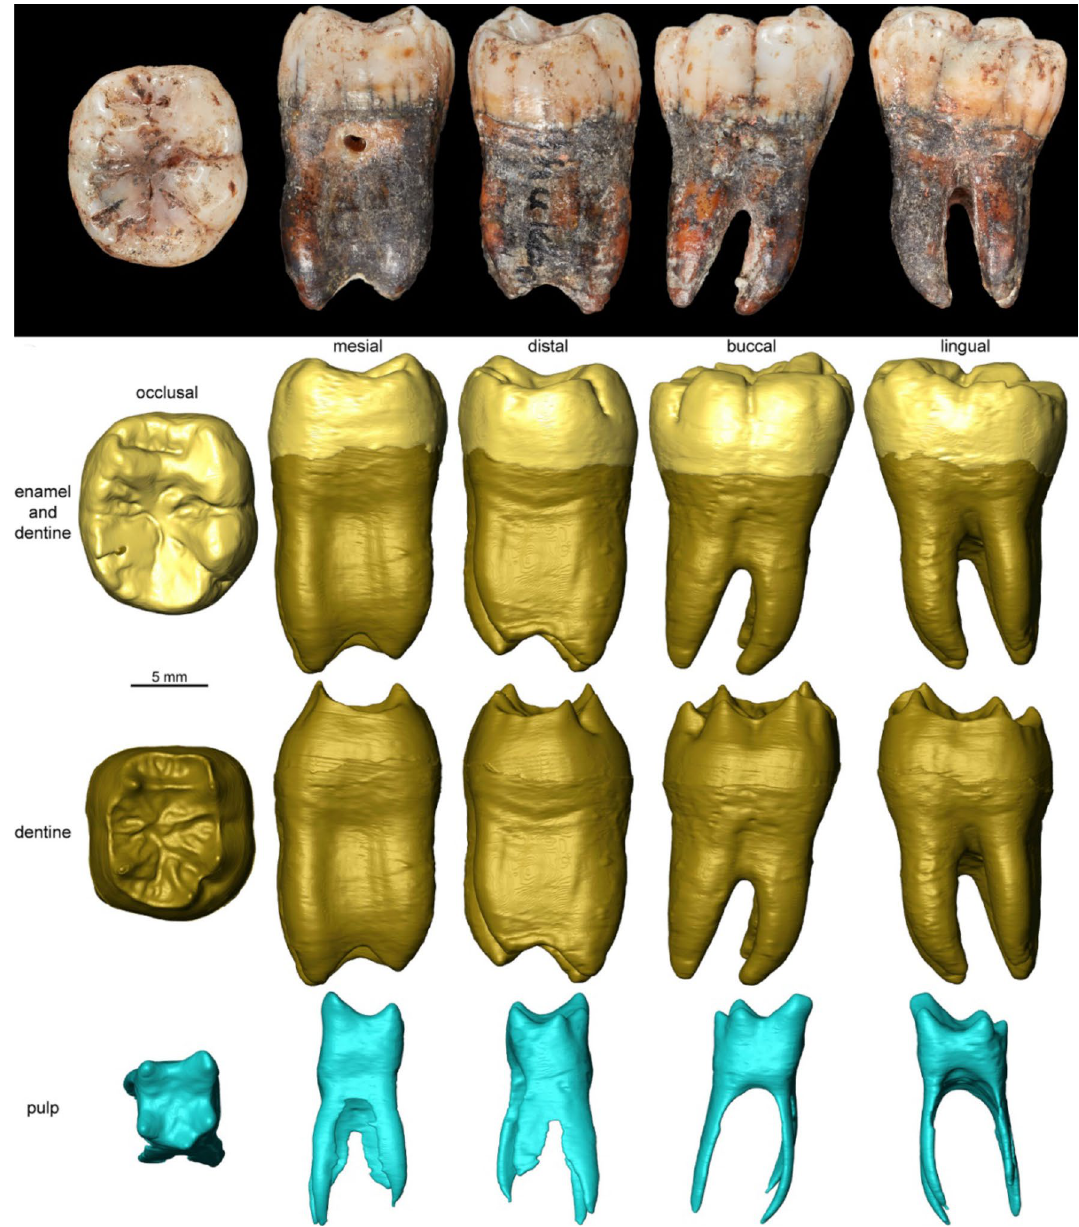
Figure 2. Photographic and Virtual rendering of EM 3869. Photographic and Microtomographic-based 3D surfaces of the external morphology, dentine and pulp are illustrated in occlusal, mesial, distal, buccal and lingual